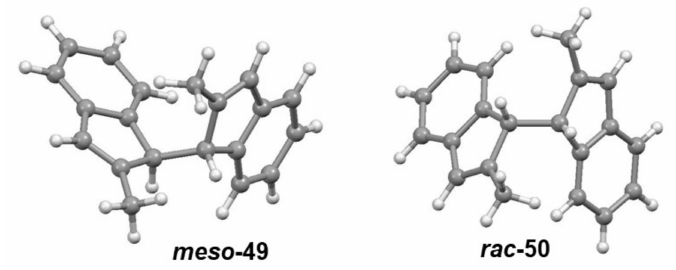
Figure 24. Molecular structures of meso - and rac -2,2 (cid:48) -dimethyl-1,1 (cid:48) -biindenyl, 49 and 50